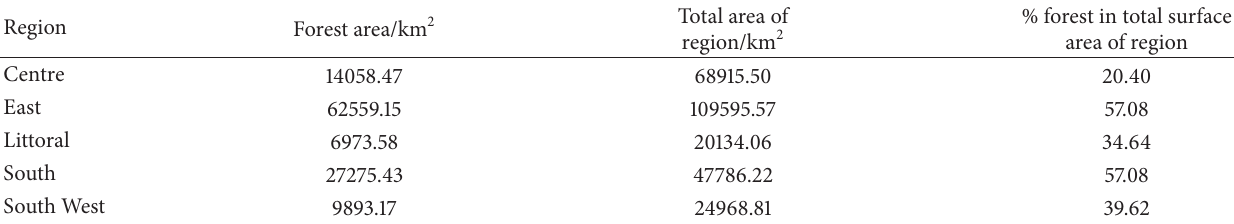
Table 3: Comparison of forest areas as a percentage of total surface area of regions in Cameroon.